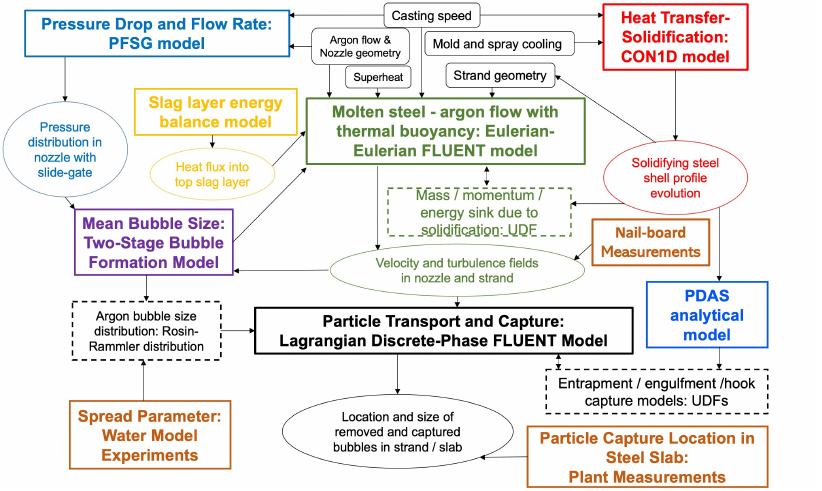
Figure 1. Model flow